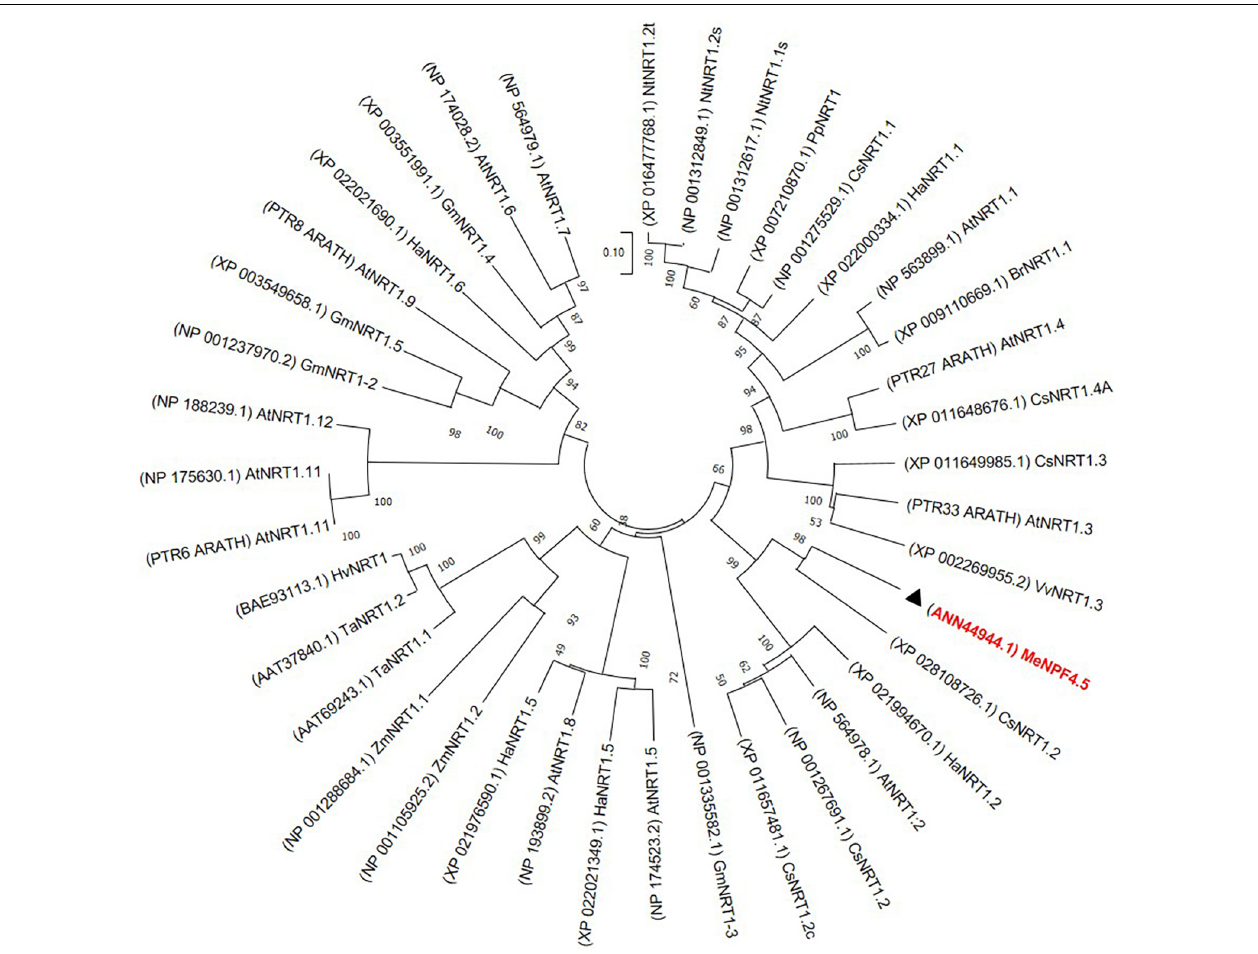
FIGURE 1 | Phylogenetic analysis of the MeNPF4.5 protein and other NO 3 − transporters (NRTs). The amino acid sequences were aligned using ClustalW software and the phylogeny was constructed using the neighbor-joining method with 1000 bootstrap replicates in MEGA7.